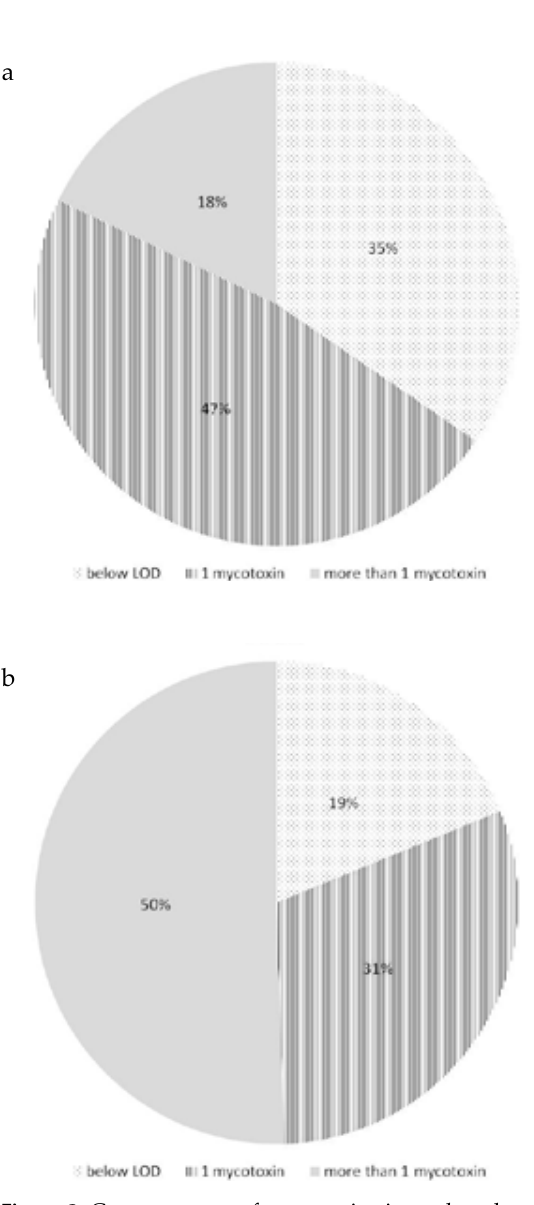
Figure 3. Co-occurrence of mycotoxins in analyzed materi- als (a, ELISA; b,